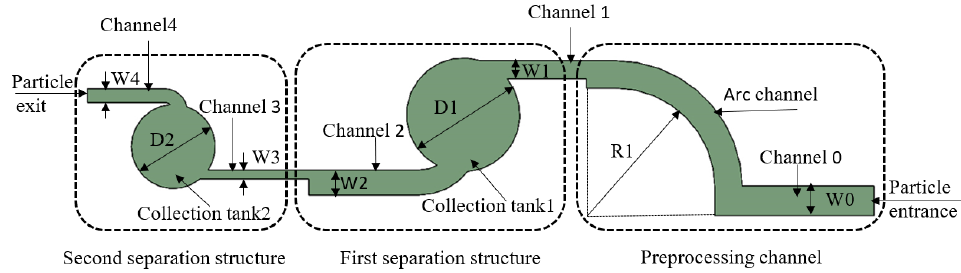
Figure 2. A 2D diagram of the microfluidic chip.